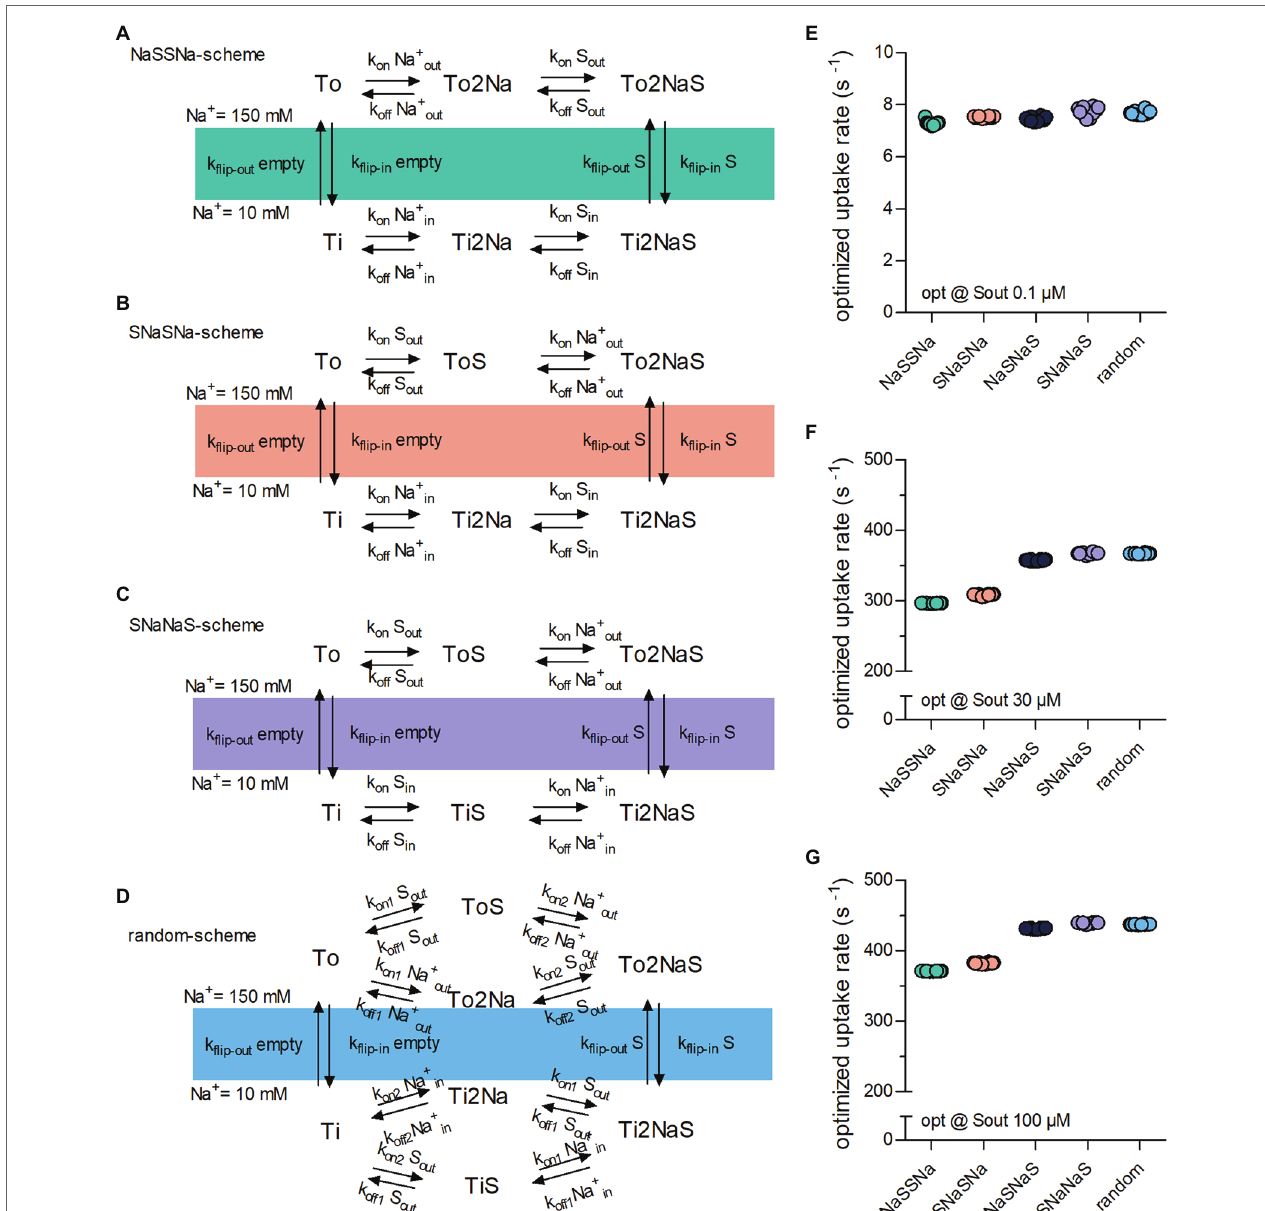
FIGURE 2 | Binding order of co-substrate and substrate affects the optimized substrate uptake rate. (A) NaSSNa scheme (sequential). Na + is the first to bind when the transporter adopts the outward-facing conformation and the last to dissociate from the inward-facing conformation. (B) SNaSNa scheme (sequential). Substrate is the first to bind to the outward-facing conformation and the first to dissociate from the inward-facing conformation. (C) SNaNaS scheme (sequential). Substrate is the first to bind to the outward-facing conformation and the last to dissociate from the inward-facing conformation (D) . Random binding order scheme. Na + and substrate bind in random order. (E) Plotted is the optimized substrate uptake rate for all schemes of transporter optimized for .1 μ M S out . At this low substrate concentration the optimized rate is approximately the same for all schemes. (F) Shown is the optimized substrate uptake rate for the different schemes optimized for 30 μ M S out . The height of the optimized rate differed between schemes (G) the same as in (F) but of transporter optimized for 100 μ M S out . The rank order of the optimized rates among schemes was the same as in (F)